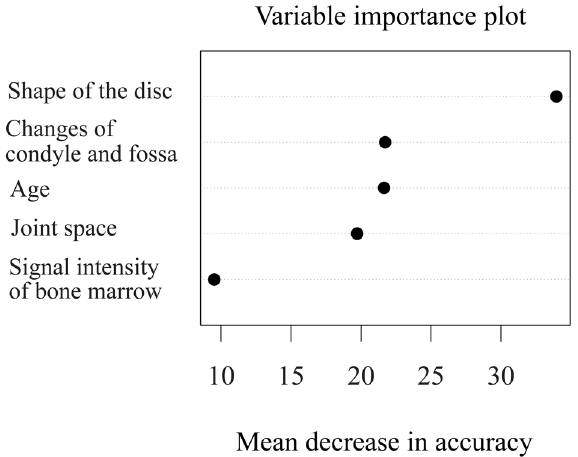
Figure 3. Plot showing importance of the variables in the random forest model. The importance is determined by the amount of reduction in uncertainty caused by arranging a variable in the tree structure. If a variable causes a large reduction in uncertainty, it occurs high up in the classification hierarchy and should thus be considered important.